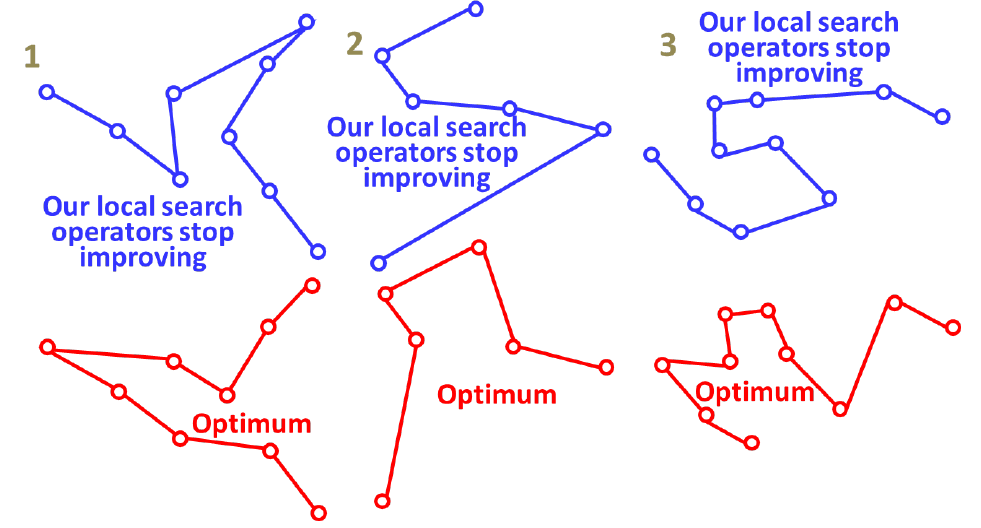
Figure 14. Examples of local optima. Repeats overcome these.